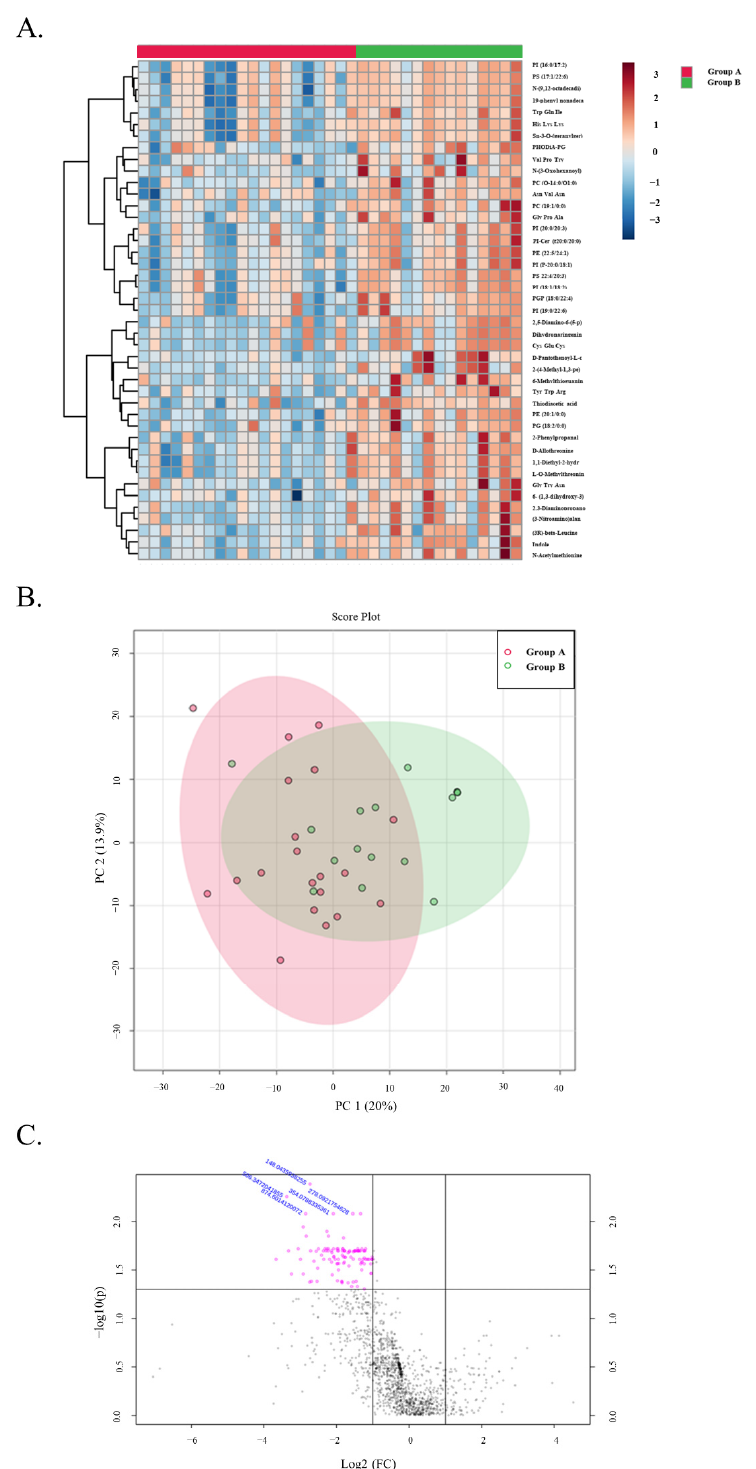
Figure 7. LP Heatmap LP PCA plot: The Top 43 metabolites in group A and B. ( A ) A heatmap visualization showing the relative intensities of metabolomic features in stool samples from patients in Group A versus Group B. Each column represents a patient’s sample, and each row represents a unique feature with a characteristic annotated mass to charge and retention time value. ( B ) A 2D PCA plot showing the overlap between Group A and Group B. ( C ) A volcano plot showing several metabolites found to be significantly (FDR < 0.05) downregulated (Log2FC < 1). The metabolites showing a negative trend could be predictors of long-term graft